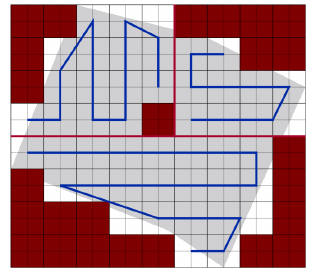
Figure 31. Planned path after partition.